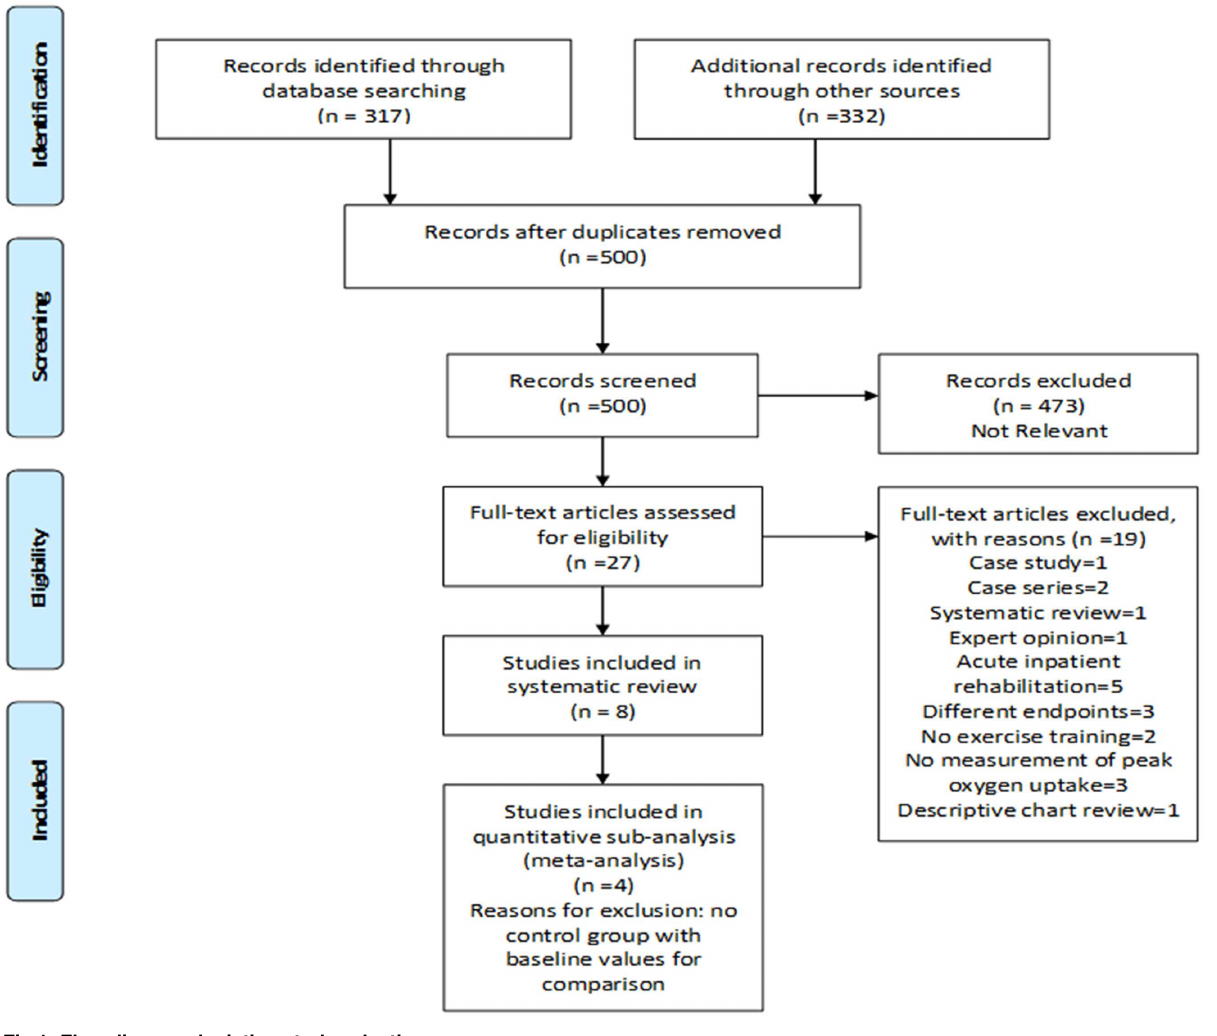
Fig 1. Flow diagram depicting study